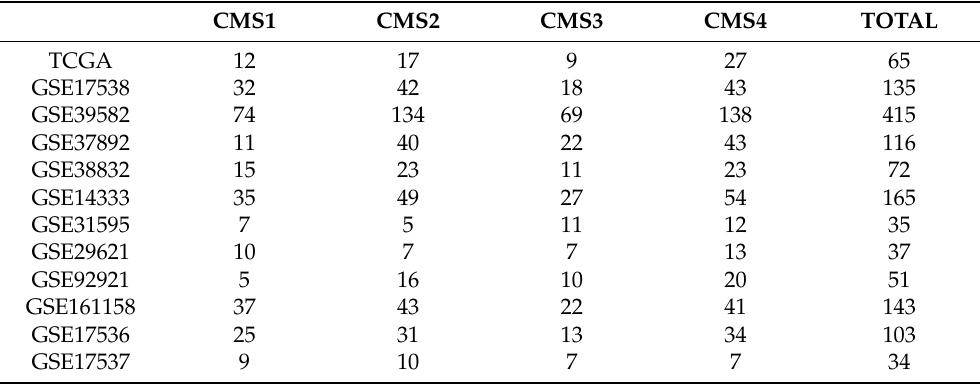
Table 4. Summary of CMS subtype patients with stage II–III